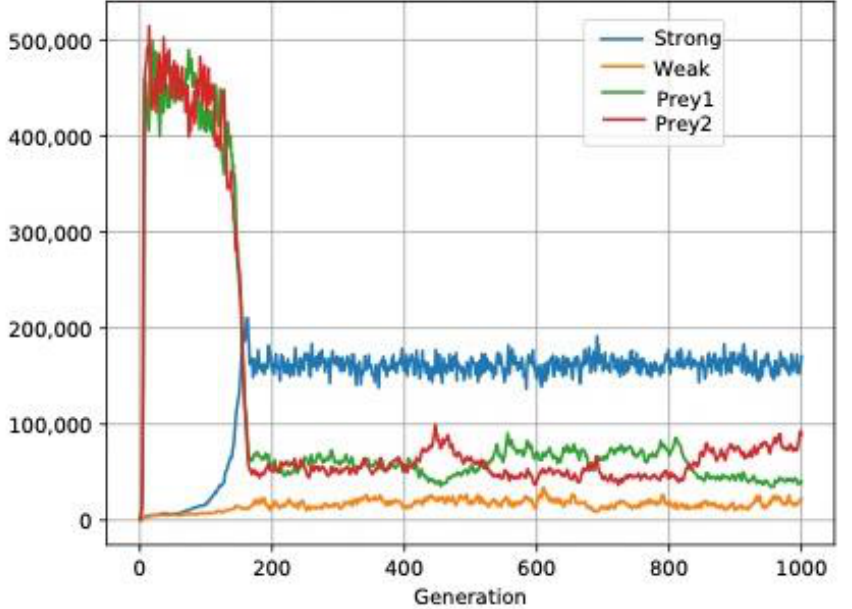
Figure 9. Generalist predators remain in equilibrium: two generalist predators and their respective prey. Strong is more efficient because it has a more uniform distribution. Although at the beginning there is a larger prey population, the dominant predator ends up being majoritarian. Neither becomes extinct.